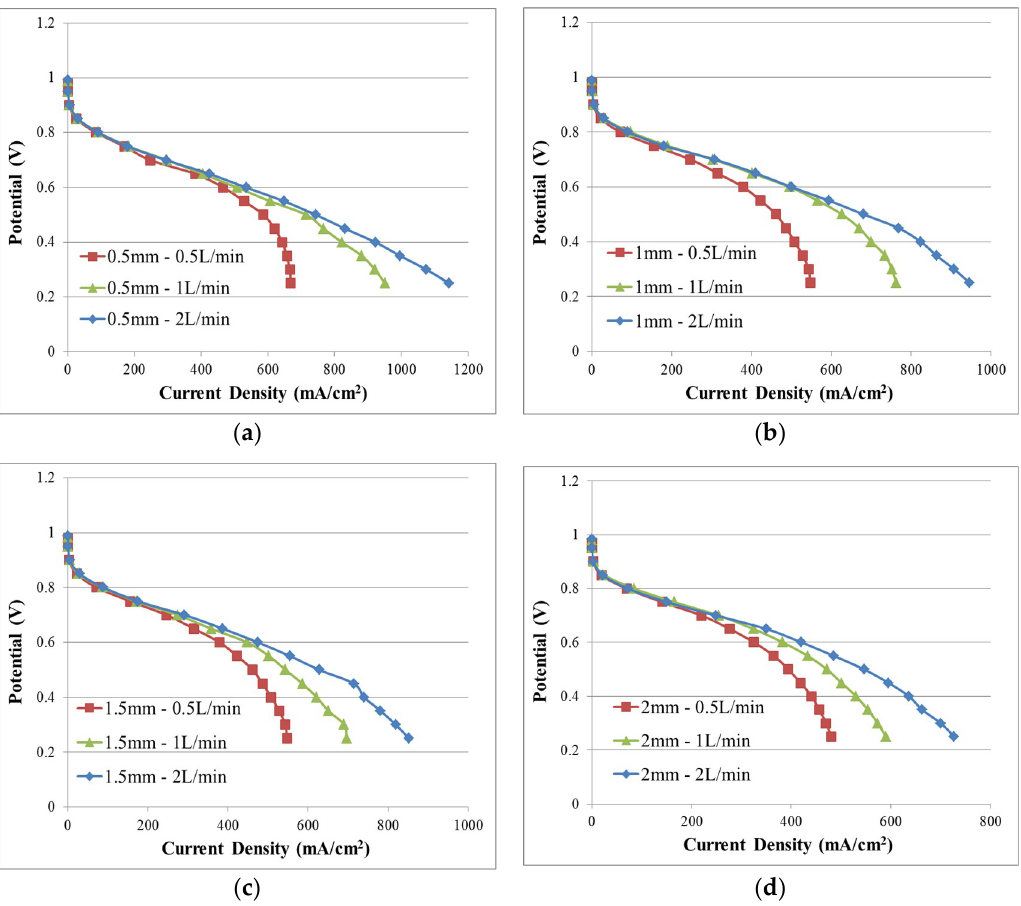
Figure 3. Comparison of polarization curves at different inlet flow rates: ( a ) Land width = 0.5 mm; ( b ) land width = 1 mm; ( c ) land width = 1.5 mm; ( d ) land width = 2 mm.